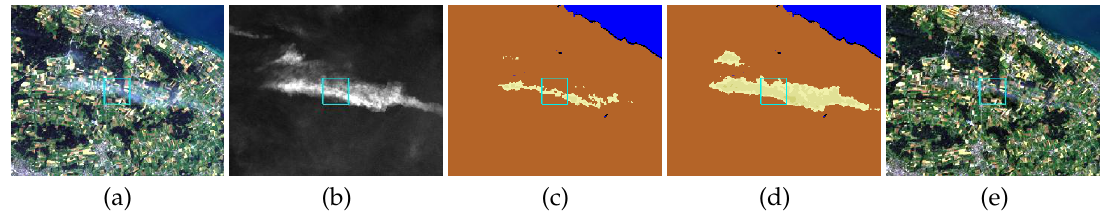
Figure 5. Landsat-8 subset, Lake Constance, 19/07/2014, ( a ) true color, ( b ) cirrus channel, ( c ) M1 cirrus mask, ( d ) M2 mask (same color coding as in Figure 2), ( e ) surface reflectance